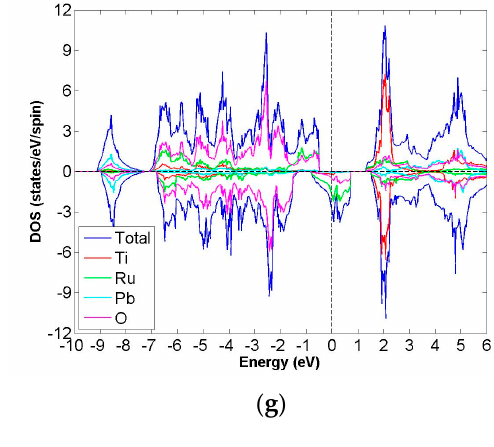
Figure 5. Based on the GGA calculation, the calculated total and partial DOS values of ( a ) Pb 2 TiRuO 6 , ( b ) Pb 2 ZrRuO 6 , ( c ) Pb 2 HfRuO 6 , ( d ) Pb 2 TiRuO 6 , ( e ) Pb 2 ZrRuO 6 and ( f ) Pb 2 HfRuO 6 and partial DOS of e g and t 2g spin orbitals for ( g ) Ti and Ru, ( h ) Zr and Ru, ( i ) Hf and Ru, ( j ) V and Ru, ( k ) Nb and Ru, ( l ) Ta and Ru.